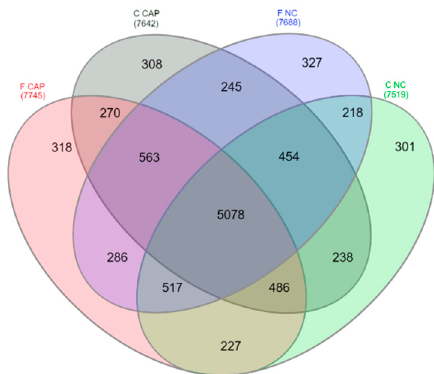
Figure 1. Venn diagram showing the distribution of ram sperm proteins between different treatments. F CAP and F NC represents the proteins detected in fresh sperm incubated under capacitating and non-capacitating conditions for all times, respectively; C CAP and C NC represent the proteins detected in cryopreserved sperm incubated under the same conditions for all times.